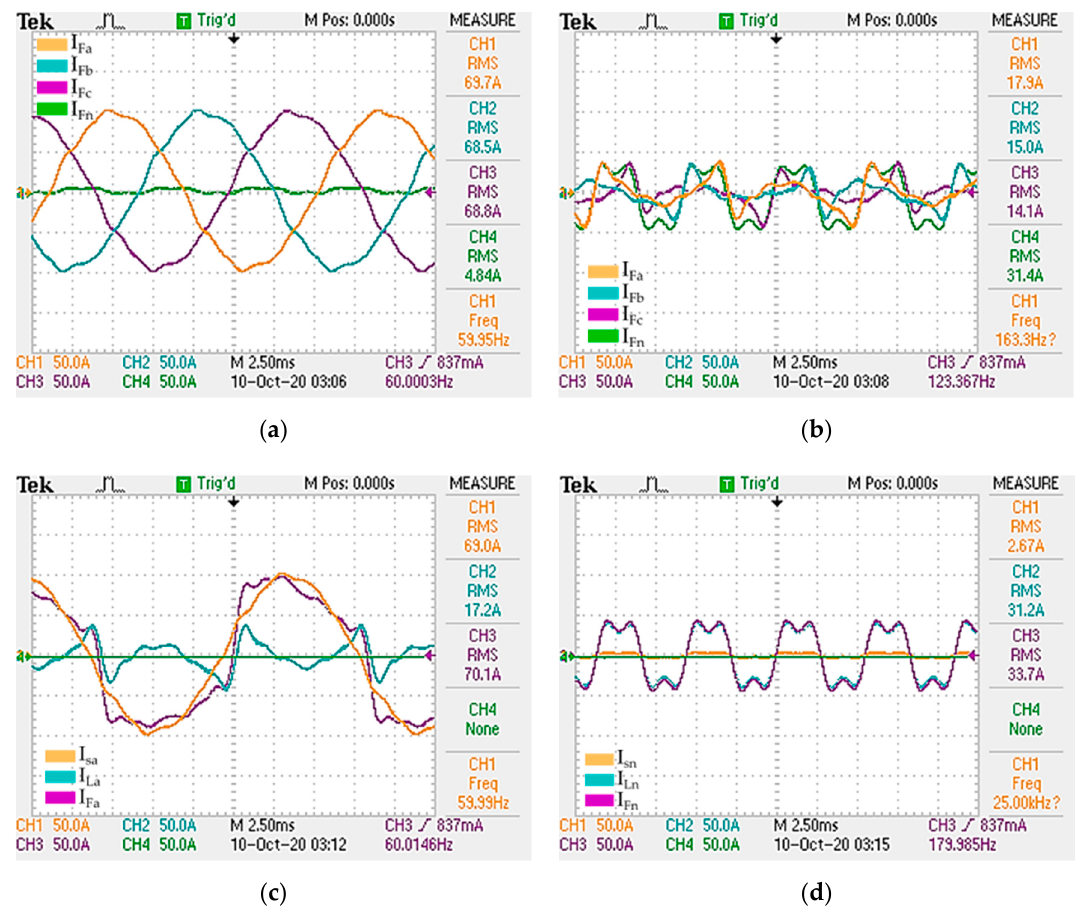
Figure 11. ES2 scenario. ( a ) 3-phase and neutral source current. ( b ) Output Filter Current. ( c ) Source, load and output filter phase-a current. ( d ) source, load and output filter neutral current. Current scale is configured to 50 A/div and time scale is configured to 2.50 ms.